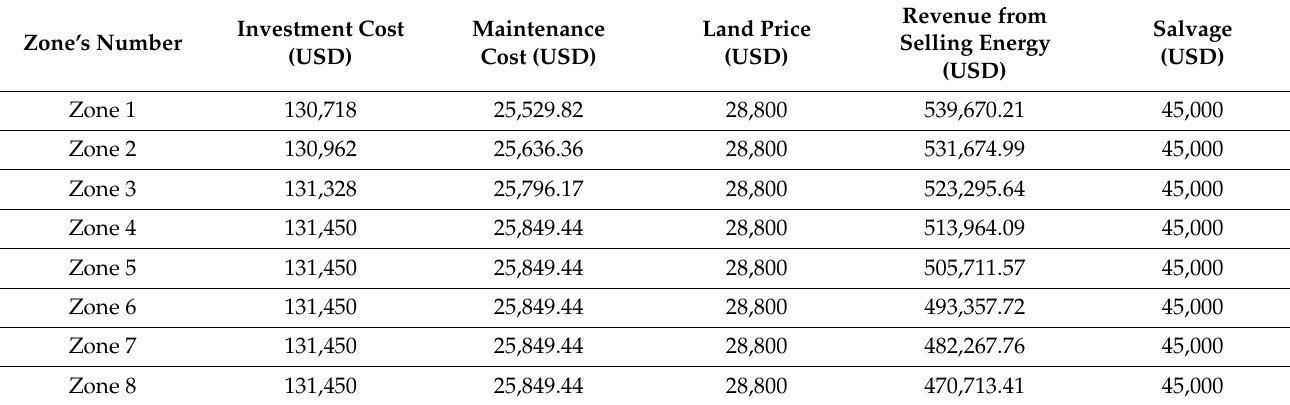
Table 8. The details of the costs/revenue in case